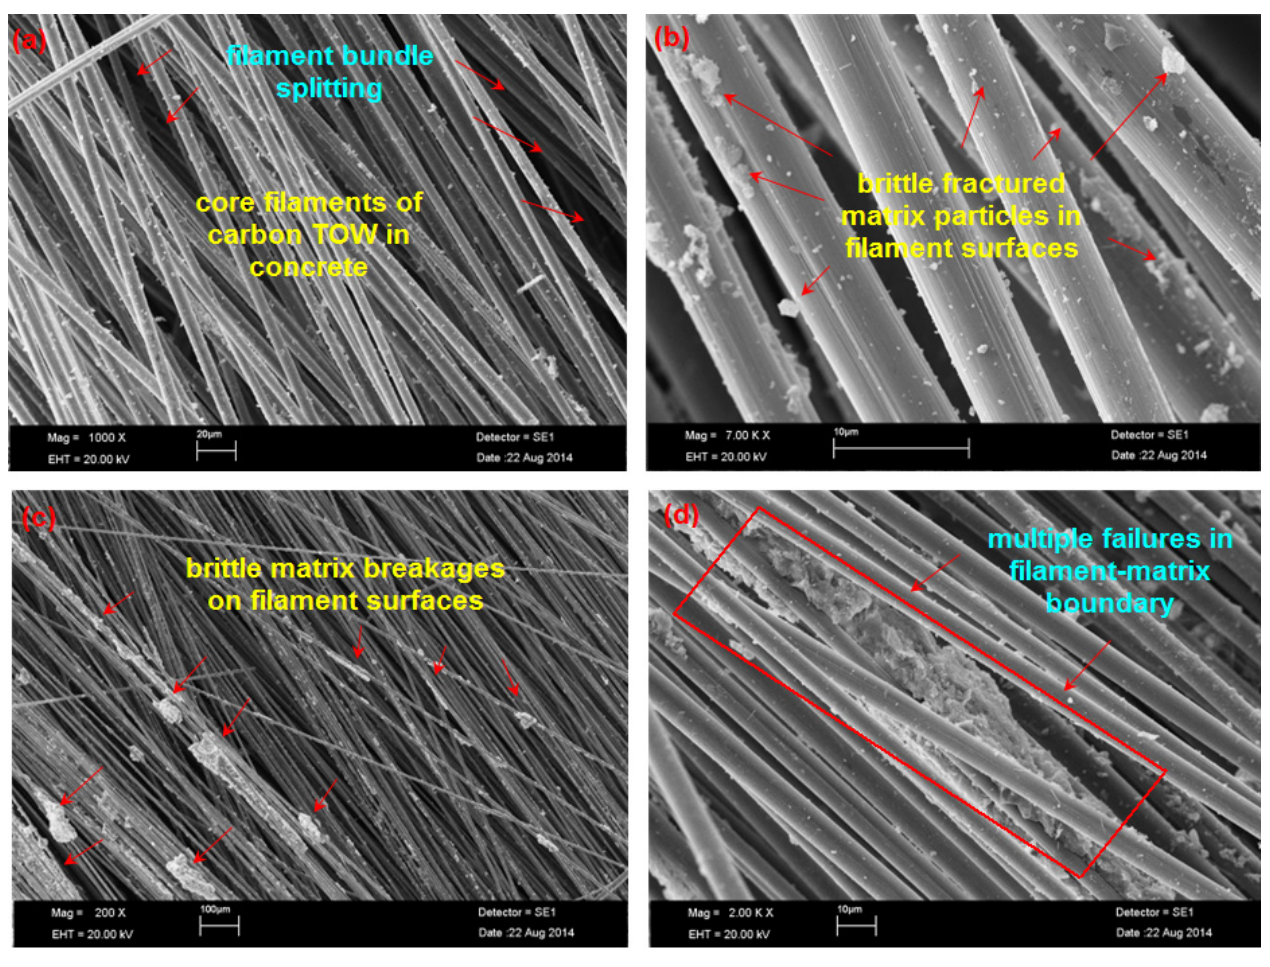
Figure 22. SEM graph of the fractured samples. ( a ) Failed fiber TOW in C-1D; ( b ) enlarge view of the failed fiber-cementitious matrix in C-1D; ( c ) failed matrix in the warp (0°) near the boundary region in C-2D; ( d ) failed filling (90°) near the boundary region in the C-2D concrete.